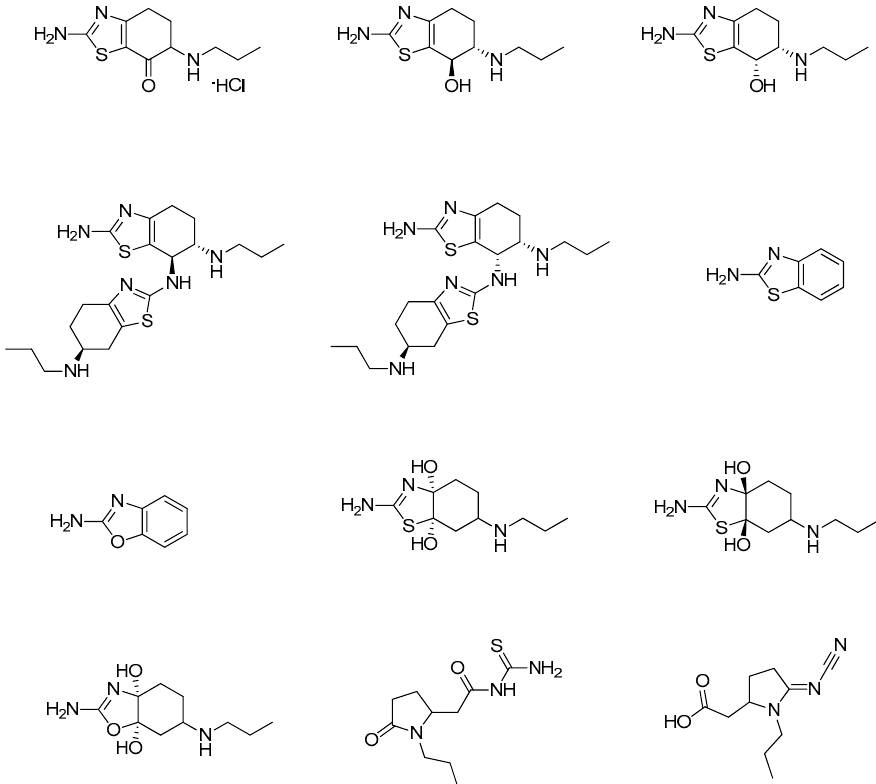
Figure 2. Chemical structures of non-pharmacopeial pramipexole related compounds